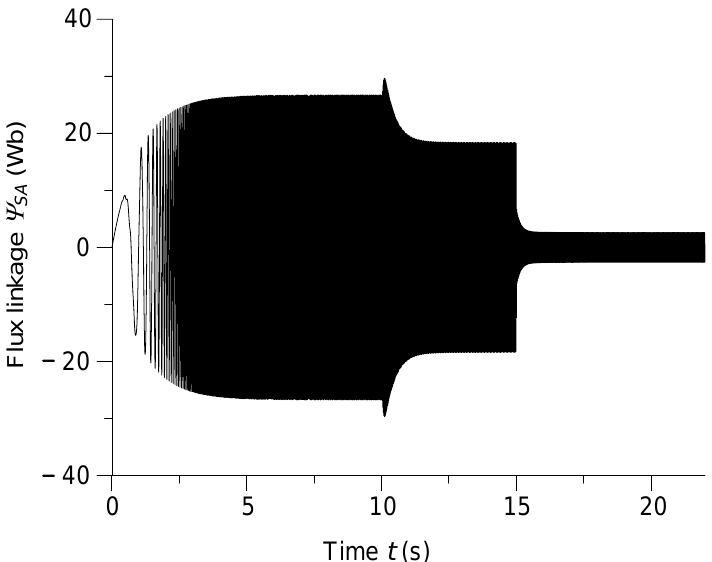
Figure 8. The instantaneous flux linkage for the A-phase armature winding of the shaft generator. Figure 9 shows the instantaneous flux linkage for the generator excitation winding.